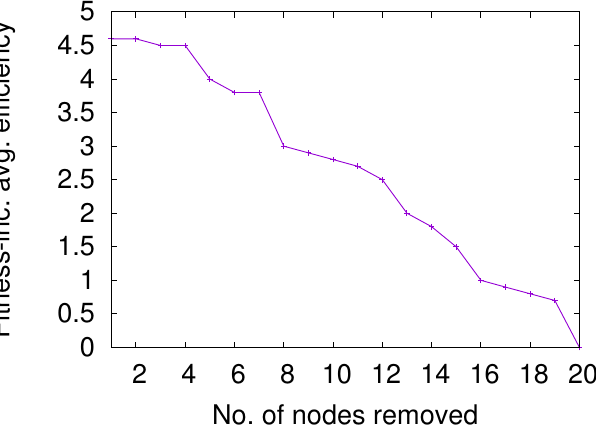
Figure 1. Sample plot showing the variation of the fitness-incorporated average